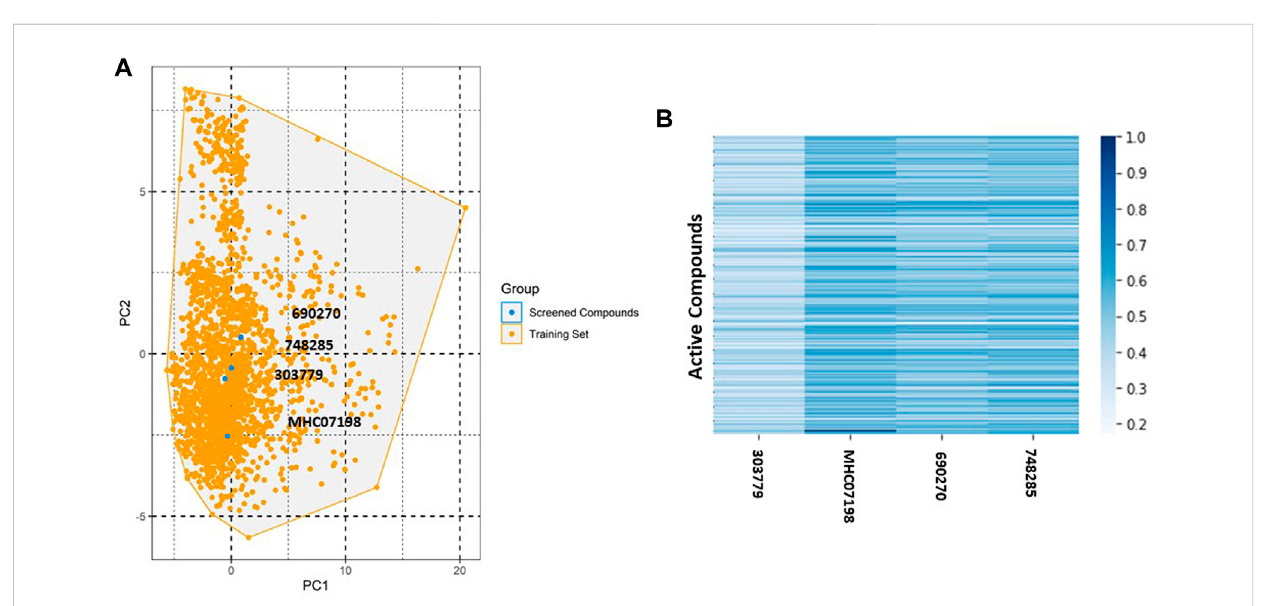
FIGURE 5 Chemicalspaceandsimilarityanalysesforselectedcompounds. (A) Chemicalspaceofselectedcompounds; (B) heatmapofthedistancematrixfor the selected compounds and active compounds in the training